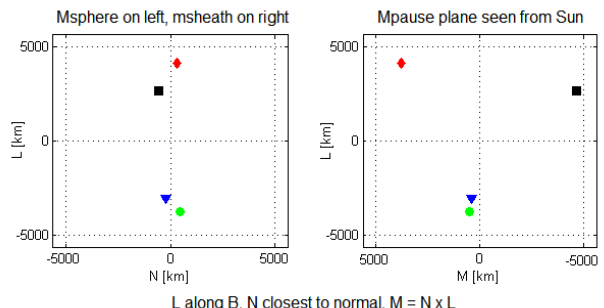
Fig. 2. Relative positions of the Cluster satellites during event 1, on 27 March 2007 at 05:10UT. The figure is drawn in boundary normal coordinates (see text for definition), where L is close to GSE Z and N close to GSE X . The origin of the plot is at ( 9 , 0 , 3 . 5 ) R E in GSE. C1 is black square, C2 red diamond, C3 green circle and C4 blue